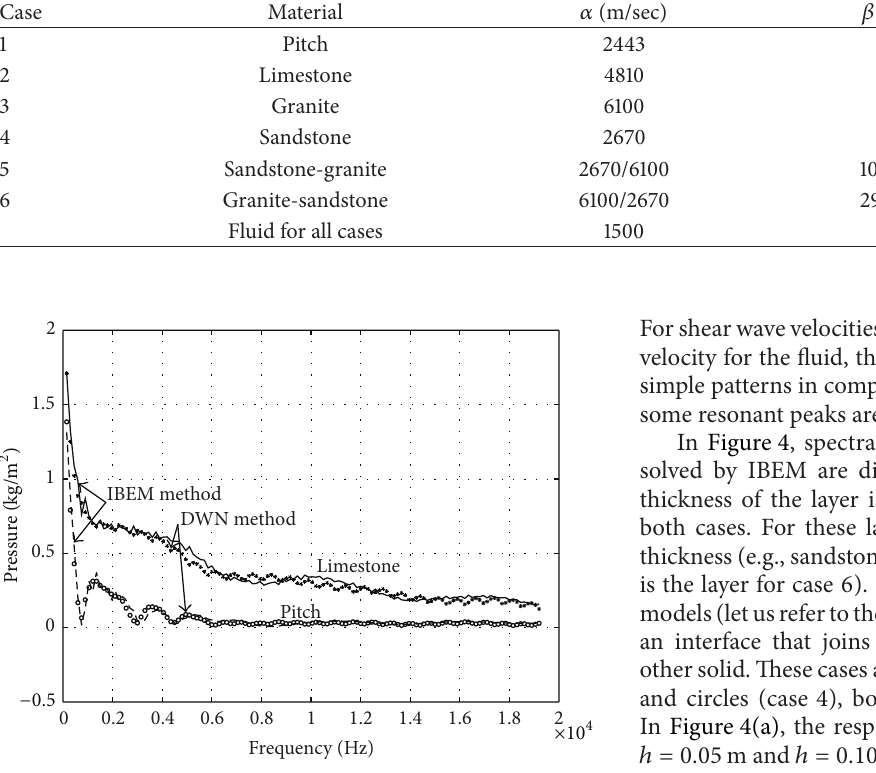
Figure 3: Results from IBEM and DWN are shown. Spectrum of pressures by IBEM, for cases 1 and 2, is plotted with solid (Lime- stone) and dashed (pitch) lines, while those obtained by DWN are displayed using asterisk (limestone) and circle (pitch) lines. Here, good agreement between both methods is also